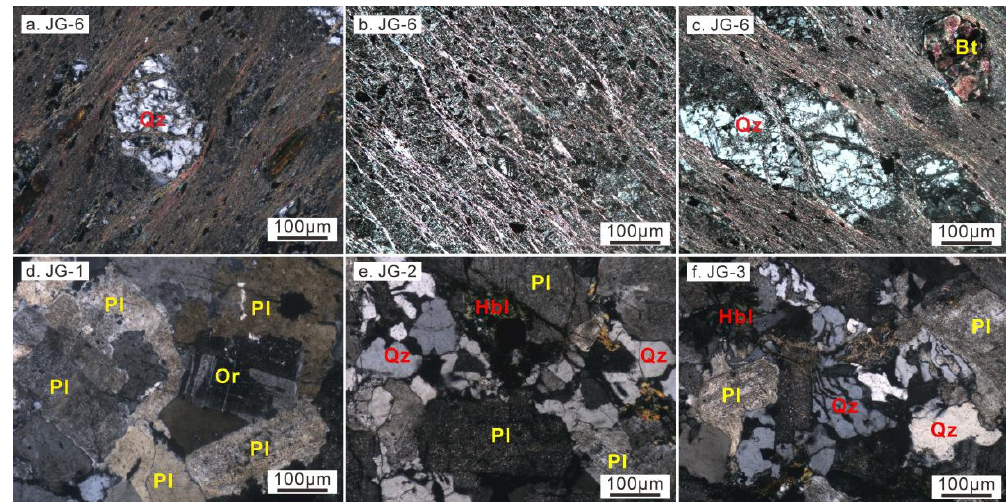
Figure 3. Field photographs of the Jin ′ gui Island showing ( a ) the sample locations and ( b – g ) different types of pebbles in the conglomerate.